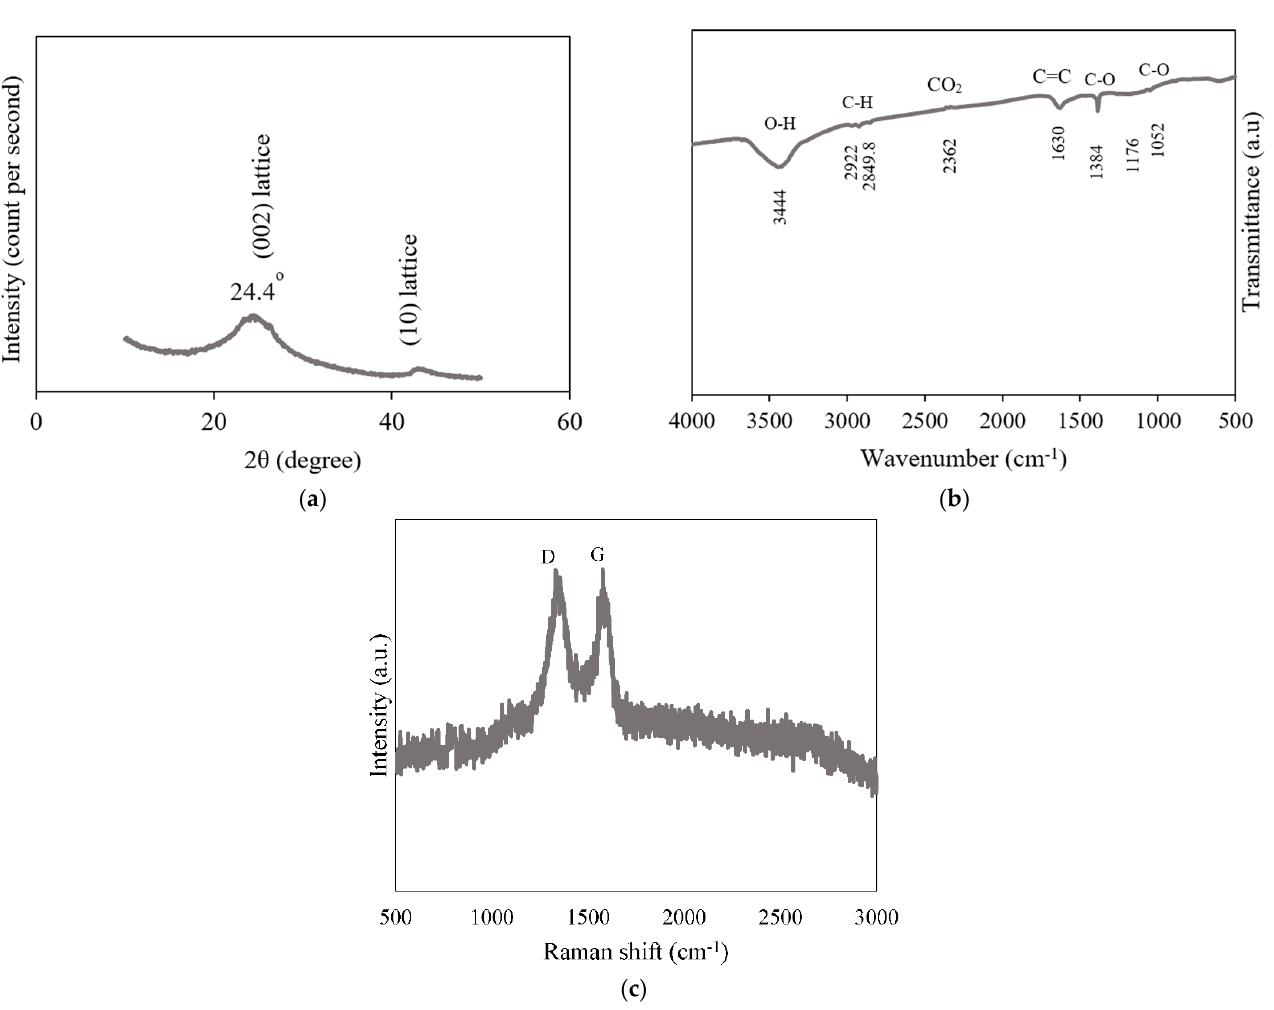
Figure 3. XRD ( a ), FTIR ( b ), and Raman ( c ) patterns recorded for as-prepared PG material.